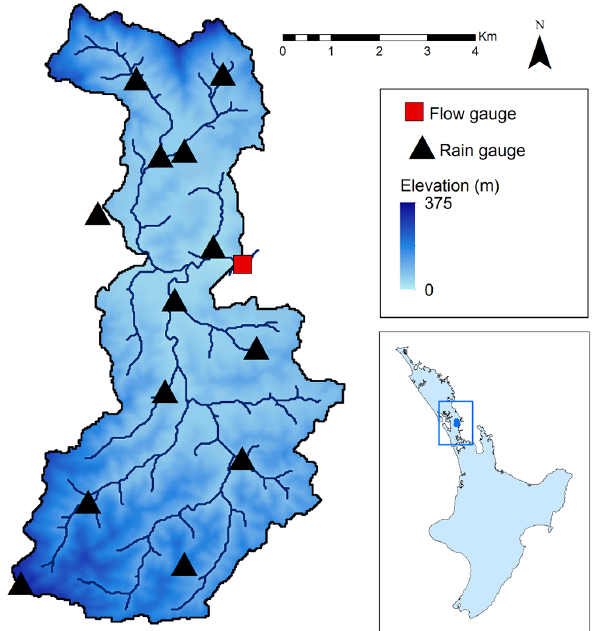
Figure 1. The Mahurangi catchment in New Zealand and the loca- tion of the rain gauges and the outlet flow gauge.